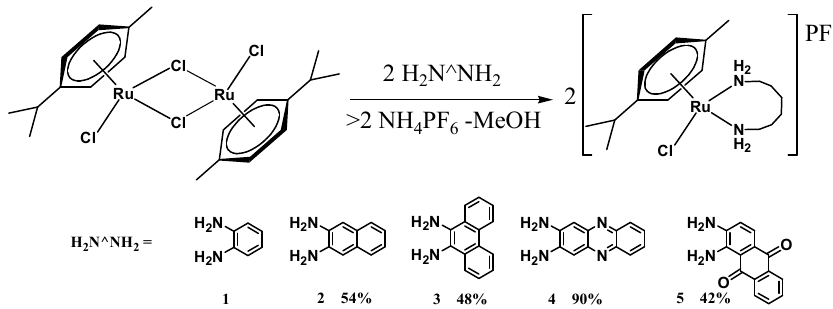
Figure 2. The changes in the 1 H-NMR of complexes 1 ( top ) and 2 ( bottom ) 30 min after the addi- tion of D 2 O to DMSO- d 6 solutions of the complexes.